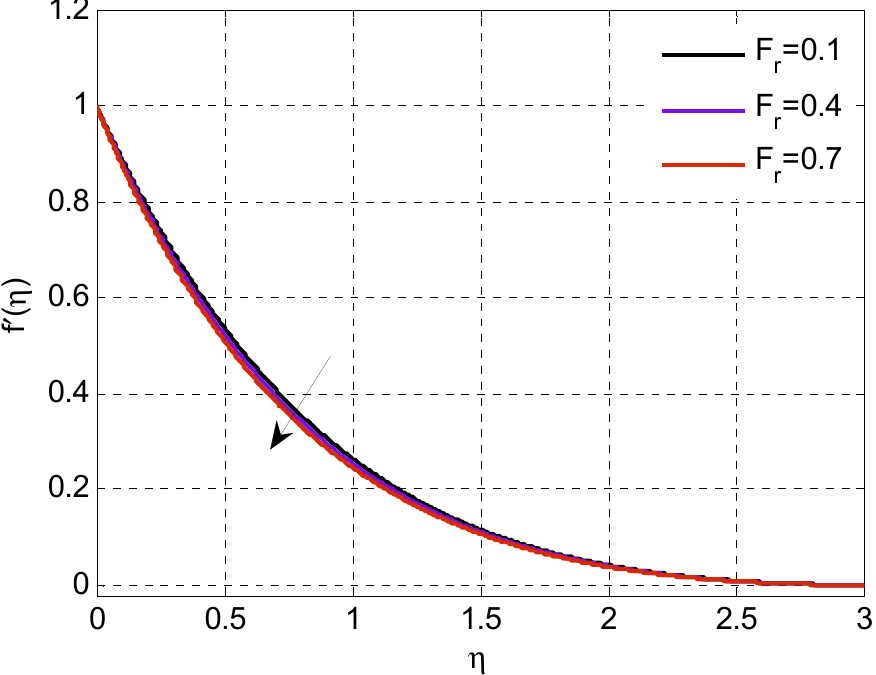
Figure 6. Effect of inertia coefficient on velocity profile using G = 1, K b = 0.9, F r = 0.1, and N = 3040 .